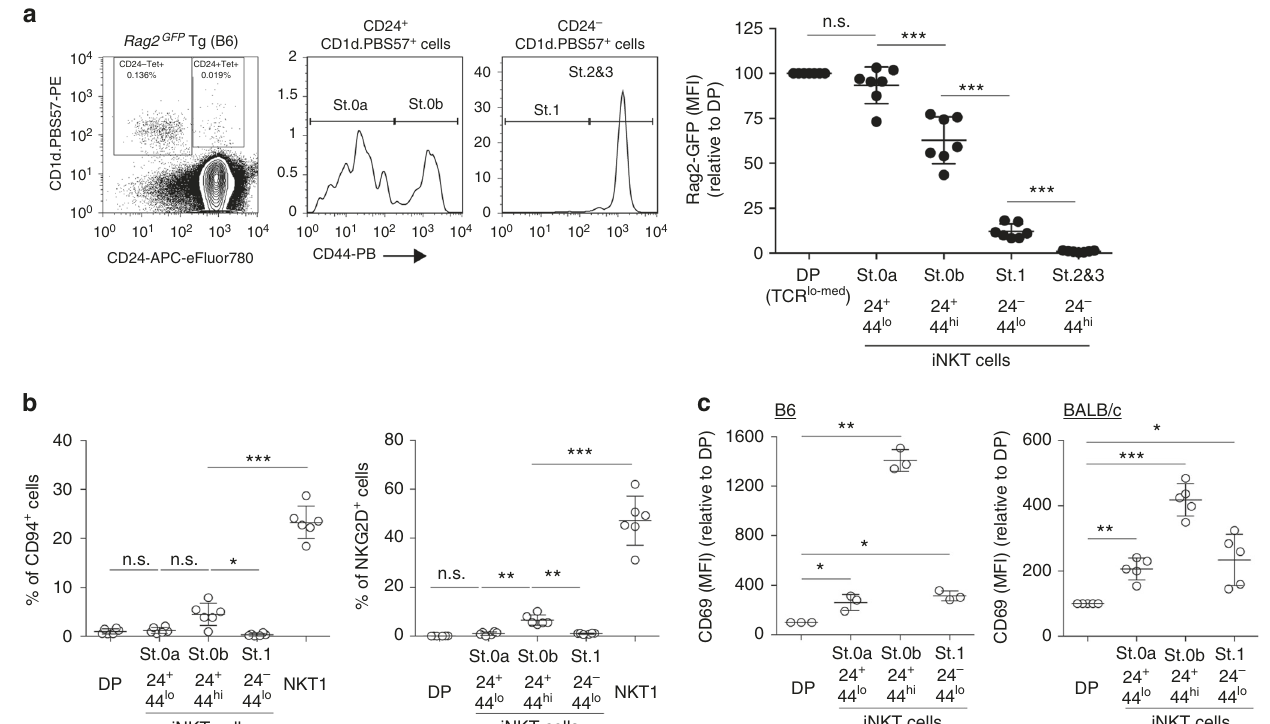
Fig. 2 CD24 + NKT precursors express CD69 but not other NK cluster genes. a The identi fi cation of cells early after positive selection using Rag2 GFP Tg mice (C57BL/6-background). CD24 + CD44 lo cells are the earliest iNKT cell progenitors (stage 0a, St. 0a) with a high RAG2-GFP expression, CD24 + CD44 med/hi cells have the second highest RAG2-GFP expression (stage 0b, St. 0b), CD24 – CD44 low cells have low Rag2-GFP expression (stage 1, St. 1), and CD24 – CD44 hi cells have no Rag2-GFP expression (stages 2 and 3, St. 2 and 3). The RAG2-GFP levels in preselection thymocytes (TCR β lo-med CD4 + CD8 + ) were set at 100, and iNKT precursors are shown relative to preselection thymocytes. b Frequencies of CD94 + or NKG2D + cells in each subset of iNKT cells from BALB/c thymus. c The CD69 expression on preselection DP cells (DP), stage 0a (St. 0a), stage 0b (St. 0b), and stage 1 (St. 1) of iNKT cells from C57BL/6 (left) and BALB/c (right) thymus presented relative to preselection thymocytes. The mean and SEM are shown. * p < 0.05, ** p < 0.01, and *** p < 0.001 (one-way ANOVA). Representative data from four experiments with seven mice are shown ( a ). Data are pooled from two experiments with six mice ( b ) and three experiments with three (C57BL/6) or six mice (BALB/c) ( c ). n.s. not signi fi